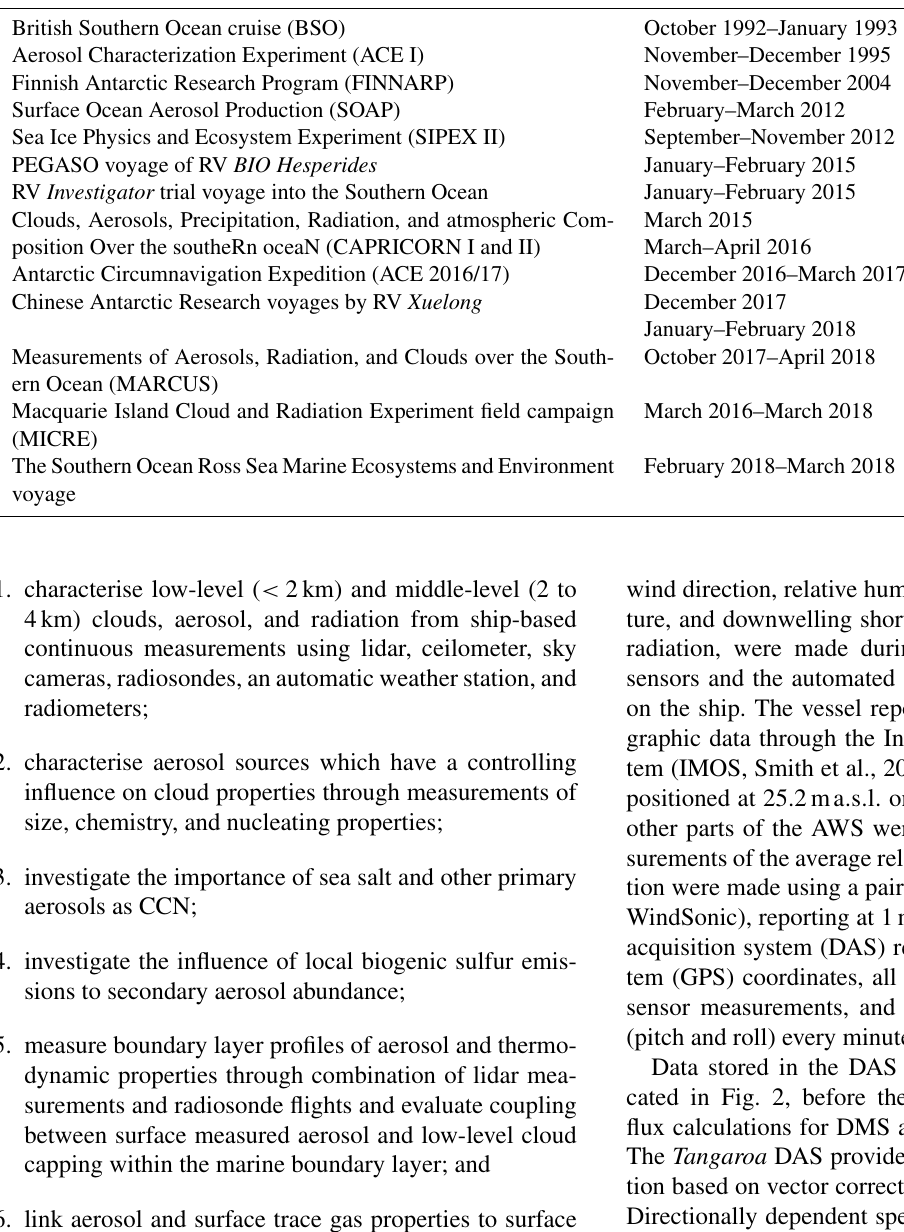
Table 1. List of previous ship- and ground-based field campaigns related to aerosol–cloud interactions over the Southern Ocean. Campaign